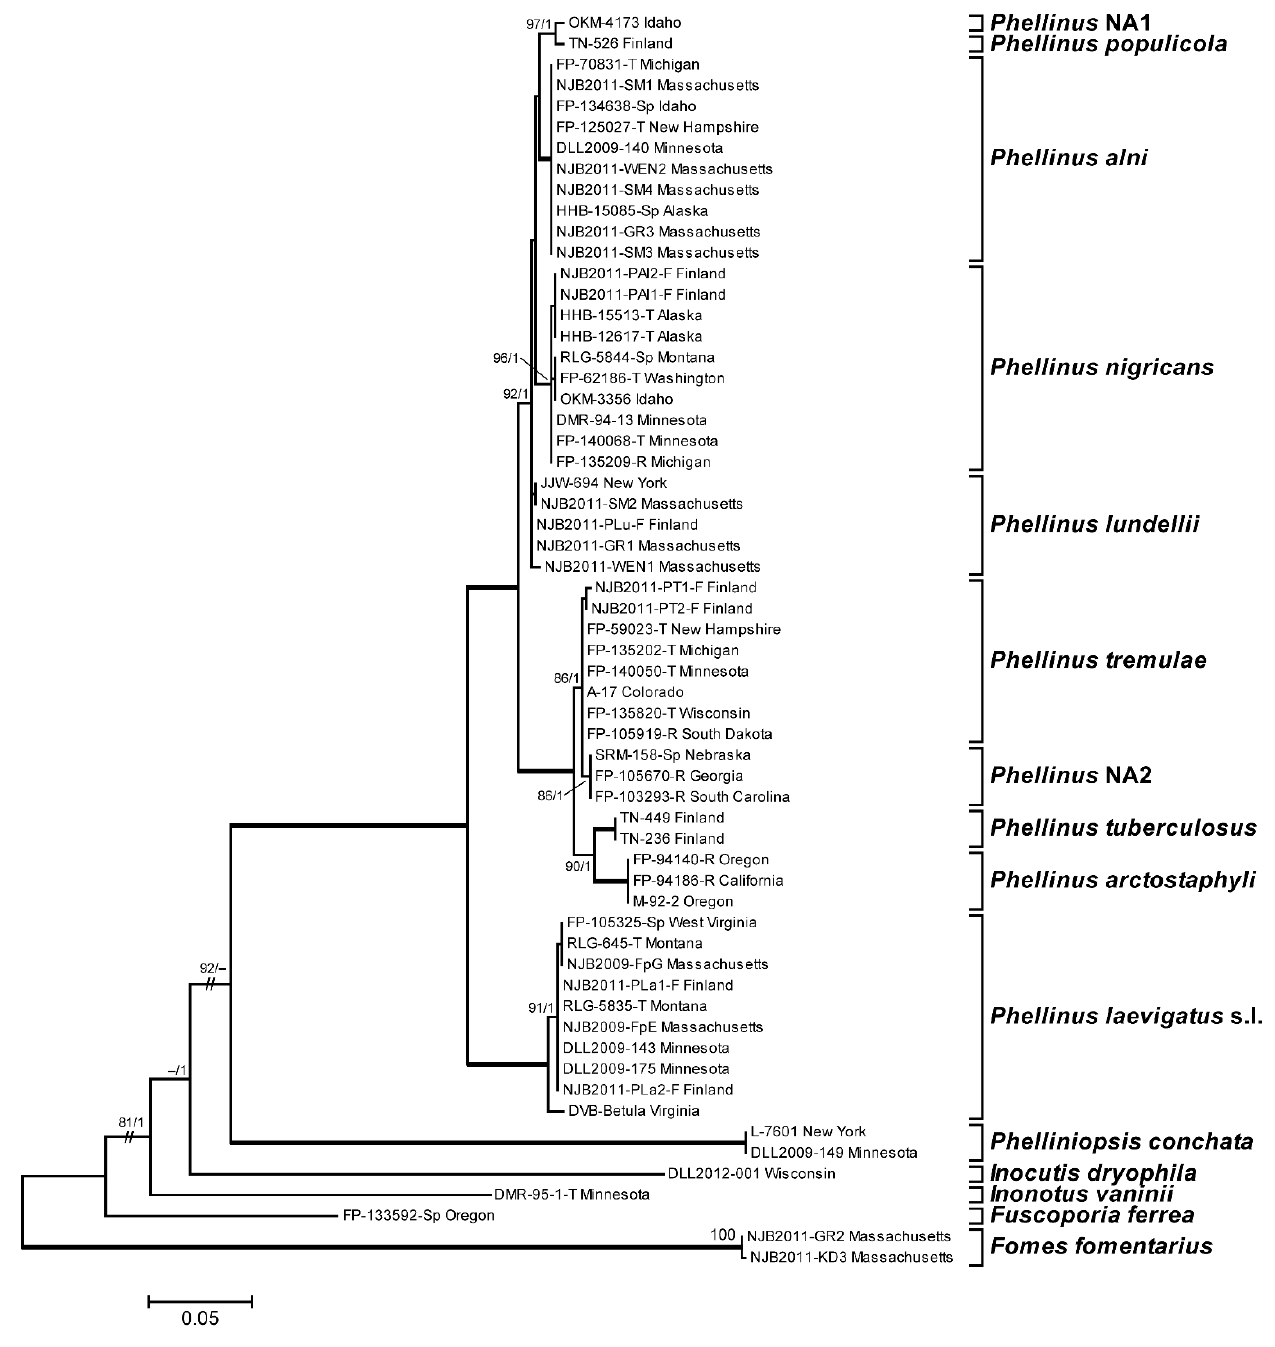
Figure 3. Maximum likelihood tree based on rpb2 sequences of Phellinus s.s. species. Bootstrap support values ≥70% and PP values ≥0.95 are shown next to the nodes. Thickened branches represent BS/PP values